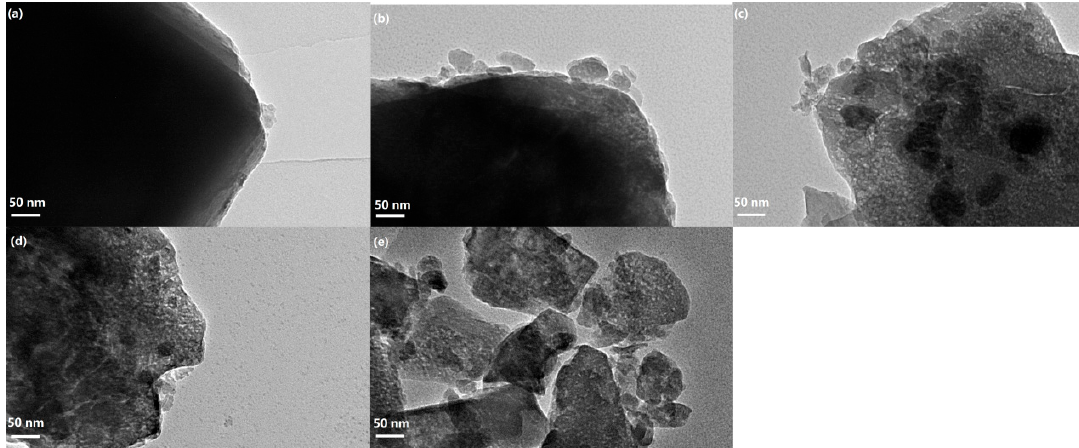
Figure 3. TEM micrographs of ( a ) HZ5 catalyst; ( b ) ATHZ5-Li catalyst; ( c ) ATHZ5-Na catalyst; ( d ) ATHZ5-K catalyst; and ( e ) ATHZ5-Cs catalyst.